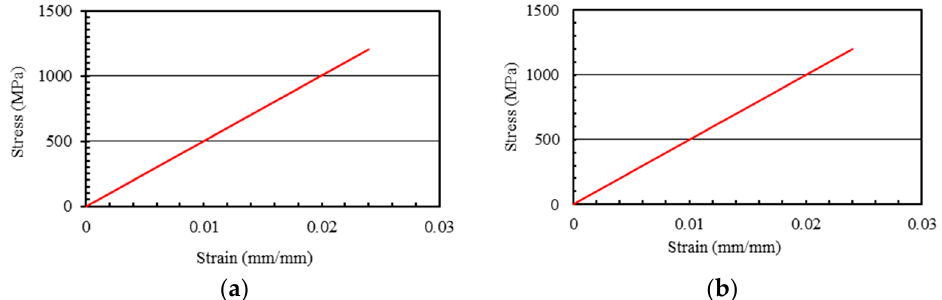
Figure 8. ( a ) Linear elastic performance of GFRP ties. ( b ) Linear elastic performance of GFRP longitudinal bars.